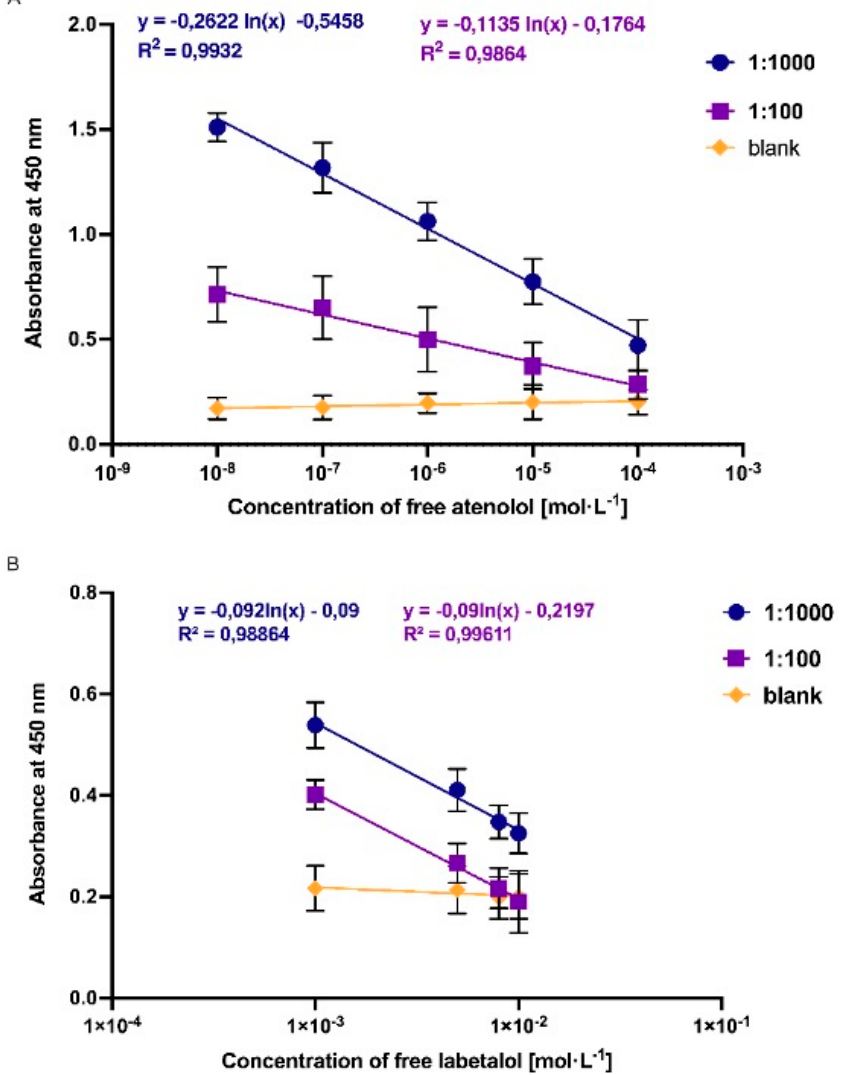
Figure 7. Results of competitive-type pseudo-ELISA assay for nanoMIPs-A and nanoMIPs-L obtained in water ( A , B ).